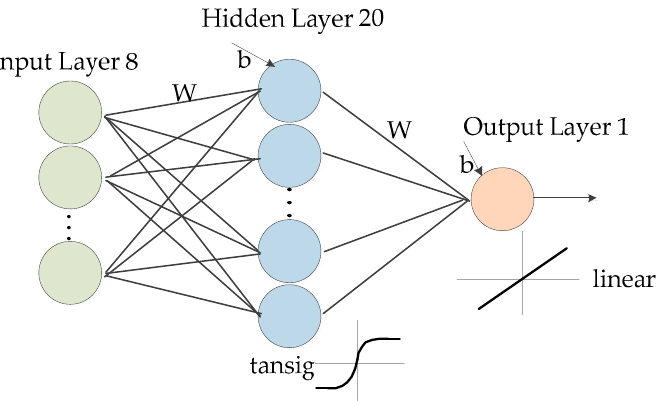
Figure 3. Artificial neural network (ANN) structure.